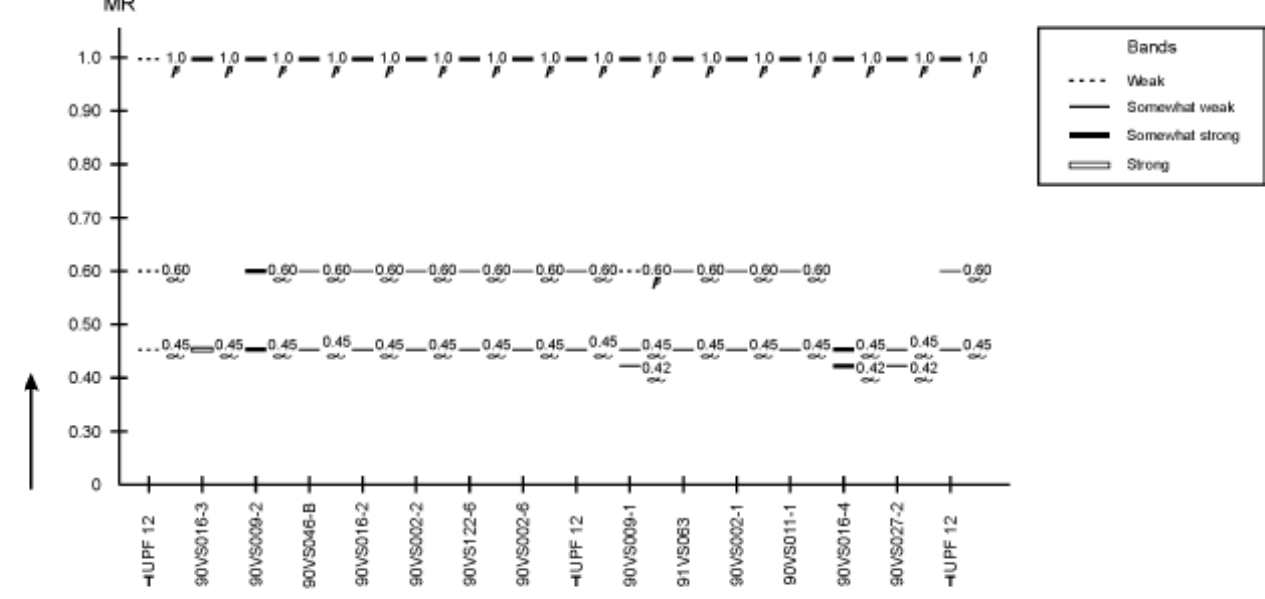
Figure 7 - Schematic representation of electrophoretic patterns for EST system in oat somaclones derived from cultivar UPF 12.